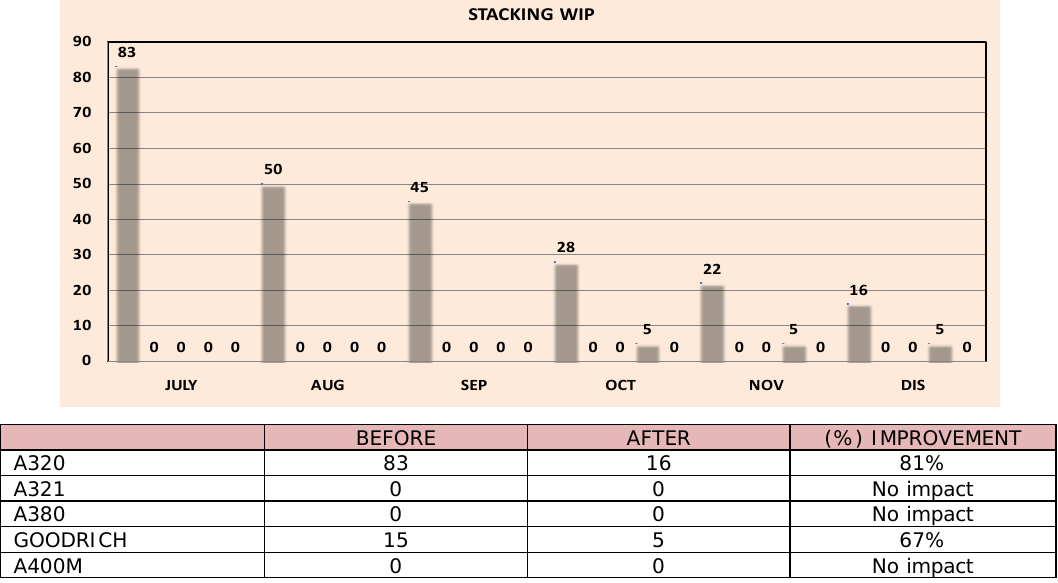
Figure 10. “Percentage of improvement for Stacking WIP